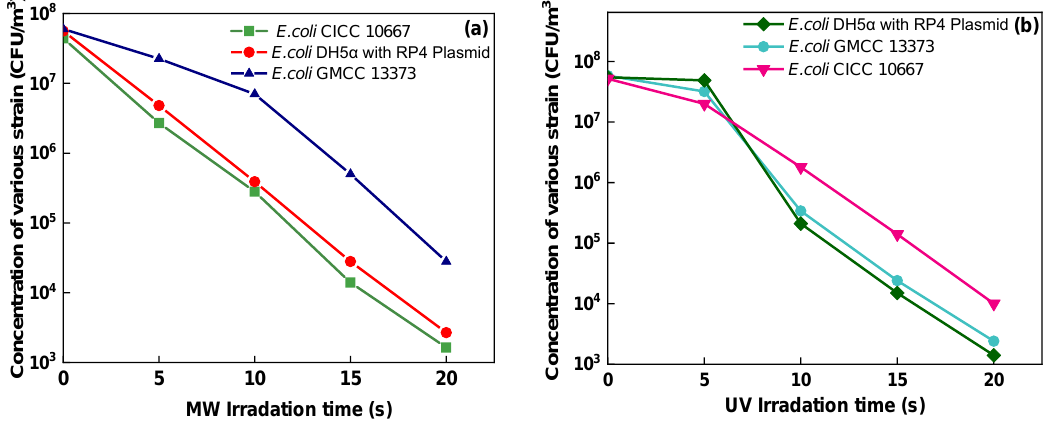
Figure 6. Concentration of various strains at different times of exposure to ( a ) MW and ( b ) UV. 3.5. Eenergy Efficiency per Order (EE/O) of Various Strains at Different Power Outputs under MW or UV Irradiation